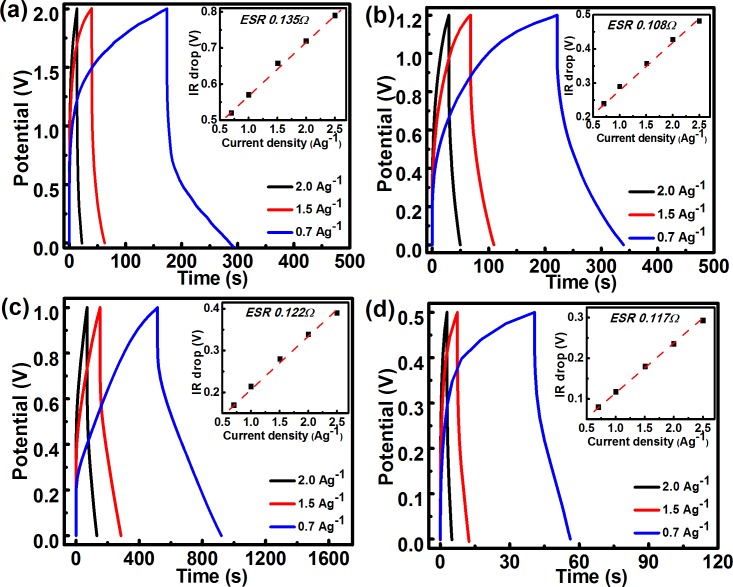
Galvanostatic charge-discharge (GCD) curves of f-MWCNT SCs at different current densities in (a) 0.1 M ACN + TBAP, (b) 1 M Na2SO4, (c) 1 M H2SO4, and (d) 1 M KOH.Insets show variation of IR drops at different current densities.